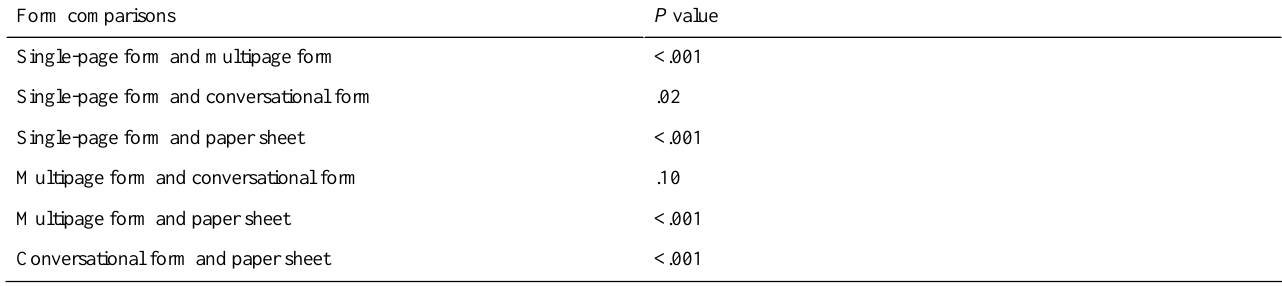
P valueForm comparisons